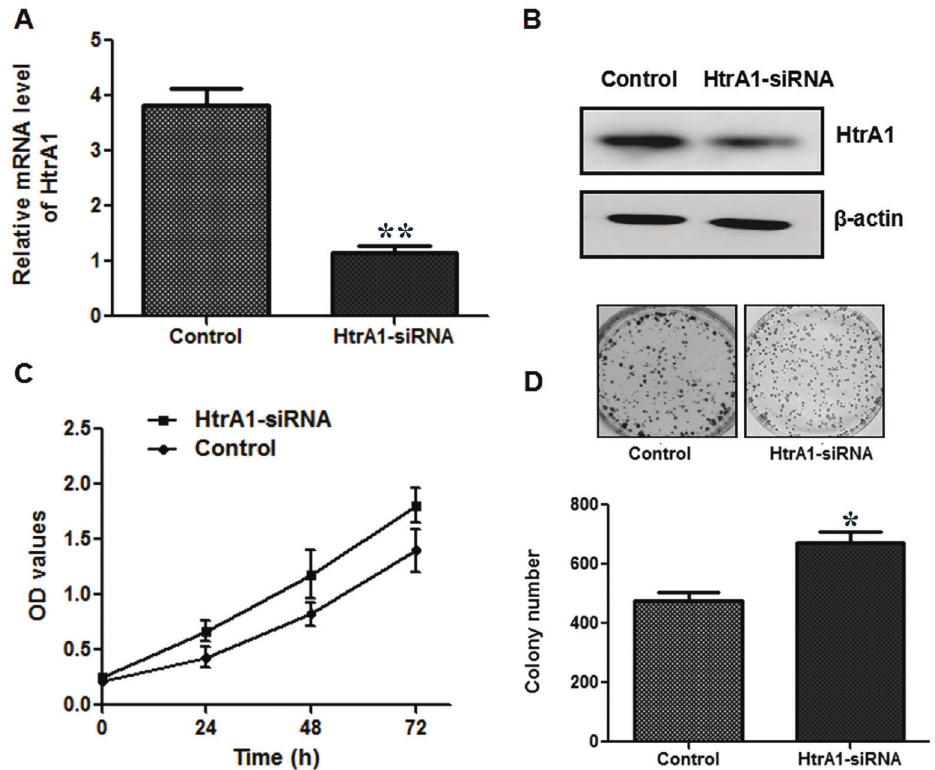
Figure 3. After transfection with high temperature requirement factor A1 (HtrA1)-speci fi c siRNA, real-time PCR ( A ) and western blot ( B ) were performed to detect the expression of HtrA1 in PANC-1 cells. Cell viability and colony number were measured by CCK-8 assay ( C ) and colony formation assay ( D ), respectively. Data are reported as means ± SD. *P o 0.05; **P o 0.01 ( t